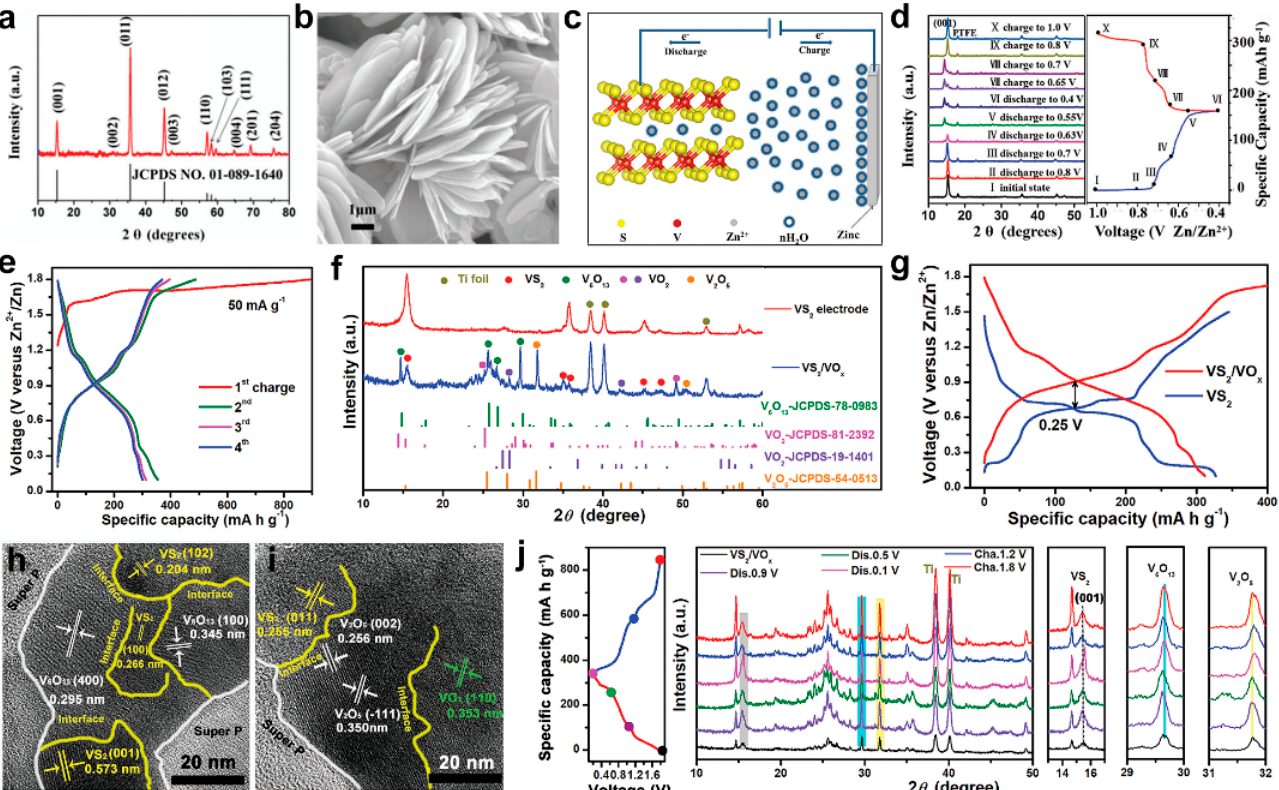
Figure 2. ( a ) The XRD of layered VS 2 [47]. ( b ) The SEM of layered VS 2 [47]. ( c ) Schematic illustration of the operation mechanism of Zn/VS 2 AZIB [47]. ( d ) Ex situ XRD patterns of layered VS 2 [47]. ( e ) Electrostatic charging and discharging curves for VS 2 [48]. ( f ) Ex situ XRD patterns of the electrode at different charge states (SOC) [48]. ( g ) The average potential of VS 2 and VS 2 /VO x under the GCD curve in the second circle [48]. ( h , i ) The HRTEM images of in situ formed VS 2 /VO x [48]. ( j ) Ex situ XRD patterns of VS 2 /VO x [48].